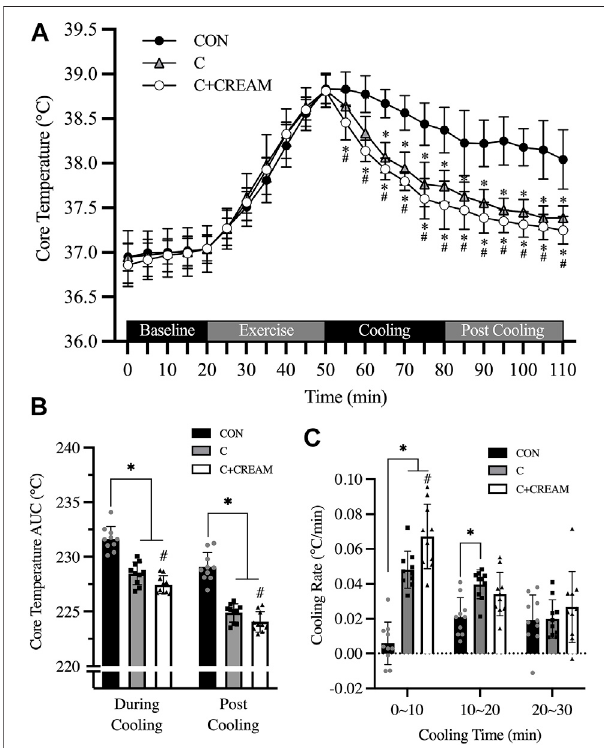
FIGURE4| Changesincoretemperature(T core ).ChangesinT core during baseline,exercise,cooling,andpostcoolinginstudy2,recordedbyingestible telemetry sensor, are presented (A) . Area under the curve (AUC) for T core during cooling and post cooling (B) and cooling rates during cooling (C) are presented. CON, control cooling; C, ice-suit cooling; C + CREAM, ice-suit cooling with cutaneous application of analgesic cream. Two-way repeated measures ANOVA with a Tukey ’ s post-hoc test for all. Data are presented as the mean ± SD ( n = 10). * p < 0.05 vs. CON. # p < 0.05 vs. C.